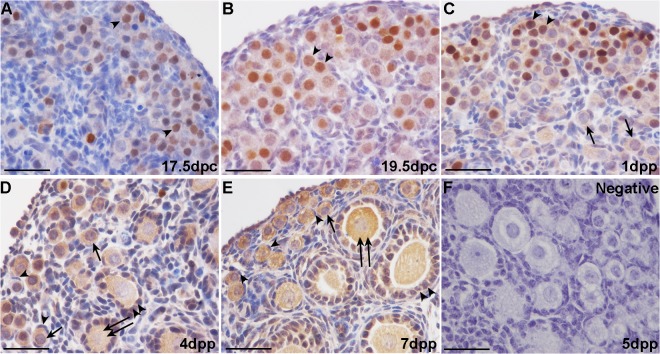
Immunohistochemical analysis of follistatin (FST) in prenatal and neonatal mouse ovaries.Weak FST staining was observed in the germ cell cytoplasm and strong staining in many germ cell nuclei (arrowheads) in 17.5 days post coitus (dpc) and 19.5 dpc mouse ovaries (A and B). FST continued to be expressed in the oocyte cytoplasm of nests and some primordial follicles (arrows) in 1 day post parturition (dpp) mouse ovaries; intense staining was observed in a portion of oocyte nuclei (arrowheads) (C). FST immunostaining in 4 and 7 days post parturition (dpp) mouse ovaries was prominent in the oocyte cytoplasm of primordial (arrows) and primary (double arrows) follicles as well as cuboidal granulosa cells (double arrowheads) of primary and growing follicles, but not in the flattened pre-granulosa cells (arrowheads) of primordial follicles (D and E). 5 dpp mouse ovaries were immunohistochemically stained with rabbit IgG as a negative control for FST (F). Scale bars: 40 μm (A-F).